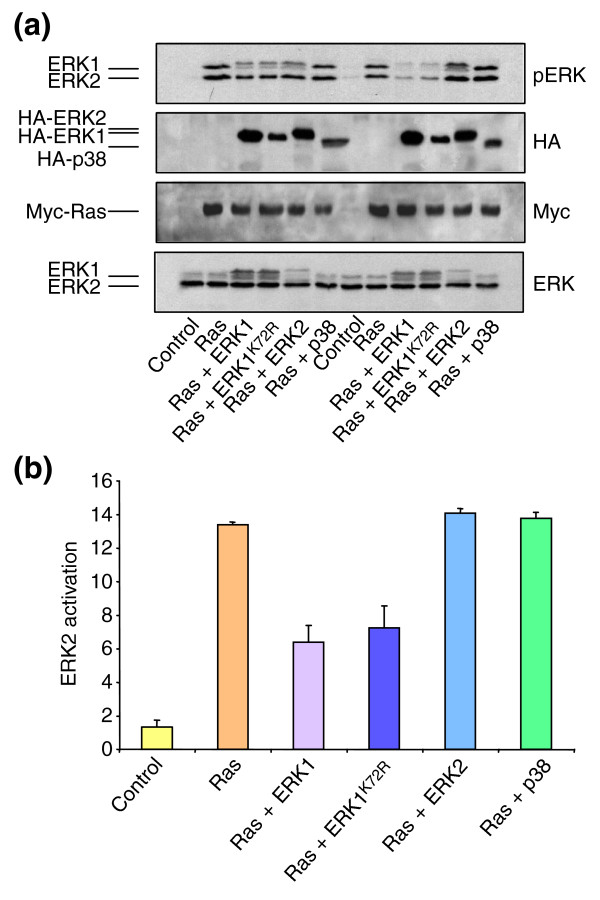
ERK2 activation is significantly reduced in tumors overexpressing ERK1. (a) Two individual tumors for each clone were explanted from treated mice and subjected to western blot analysis to determine ERK2 activation and transgene expression. (b) Mean ± SEM of the data in (a) are plotted as indicated.